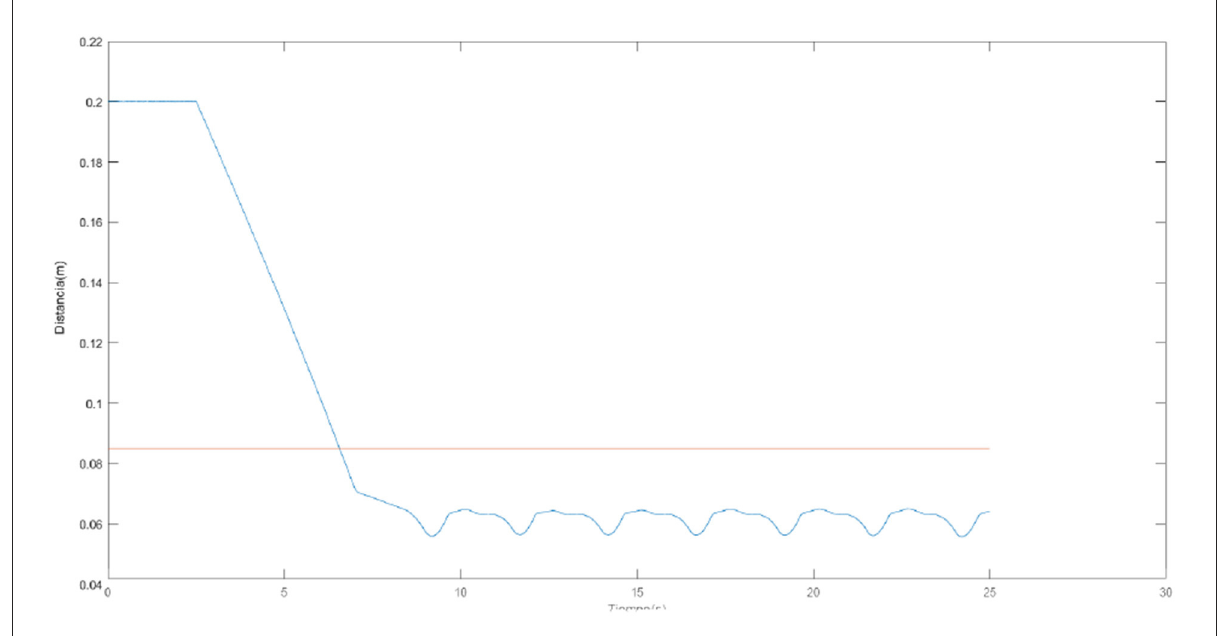
FIGURE7 Trajectory of the center of mass on the X axis.